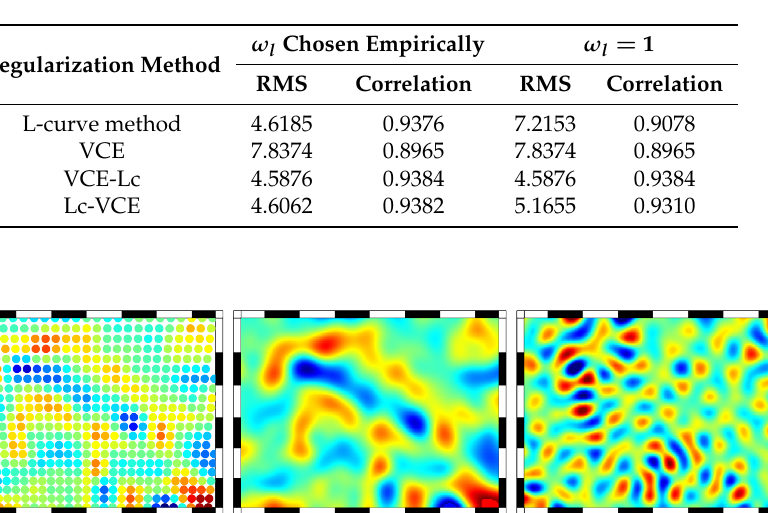
Table 3. Results of Study Case A: the root mean square error (RMS) values (unit [m 2 /s 2 ]) as well as the correlations for each regularization method, when different relative weights ω l are chosen for the L-curve method